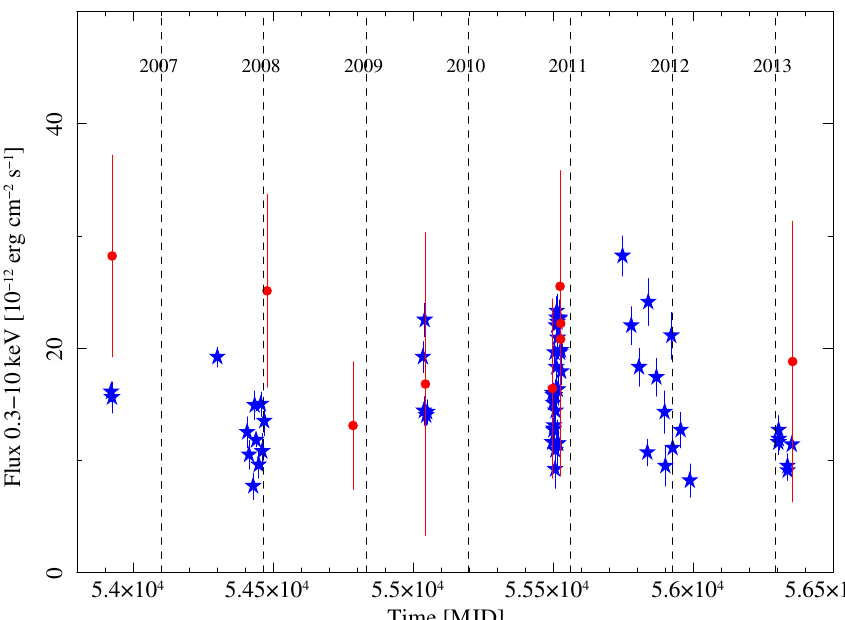
Figure 1. Swift /XRT light curve of J0324 + 3410 from the analysis reported by Foschini [11]. Blue stars indicate a best fit with a power-law model; red circles are for a broken power-law model. The vertical lines for the years are placed on 1 January of each